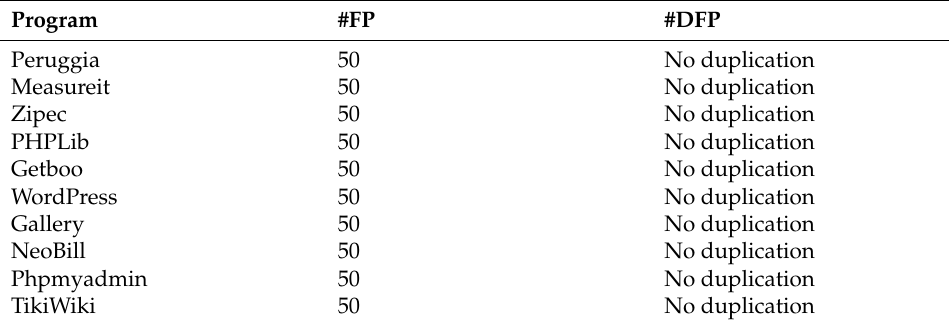
Table 7. Manually validation of 50 detected feasible